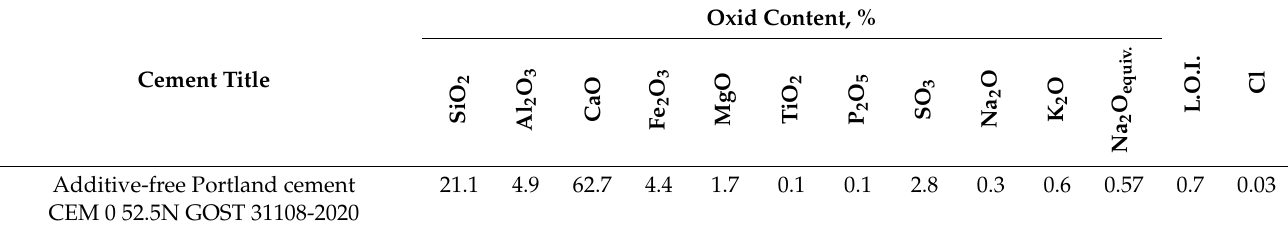
Table 2. Chemical composition of Portland cement.